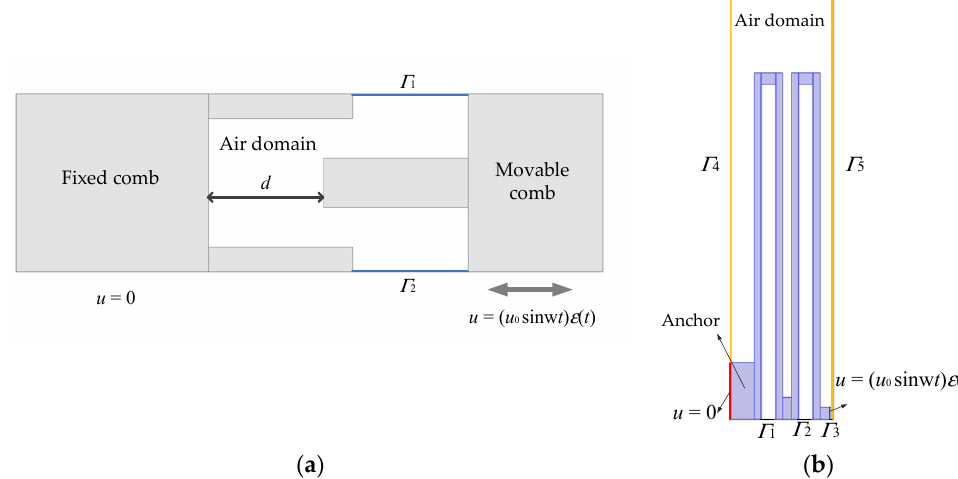
Figure 7. Incompressible fluid damping model: ( a ) 2D schematic diagram of the fluid-solid coupling model of the comb tooth unit; ( b ) 2D schematic diagram of the fluid-solid coupling model of the folded-flexure suspension.